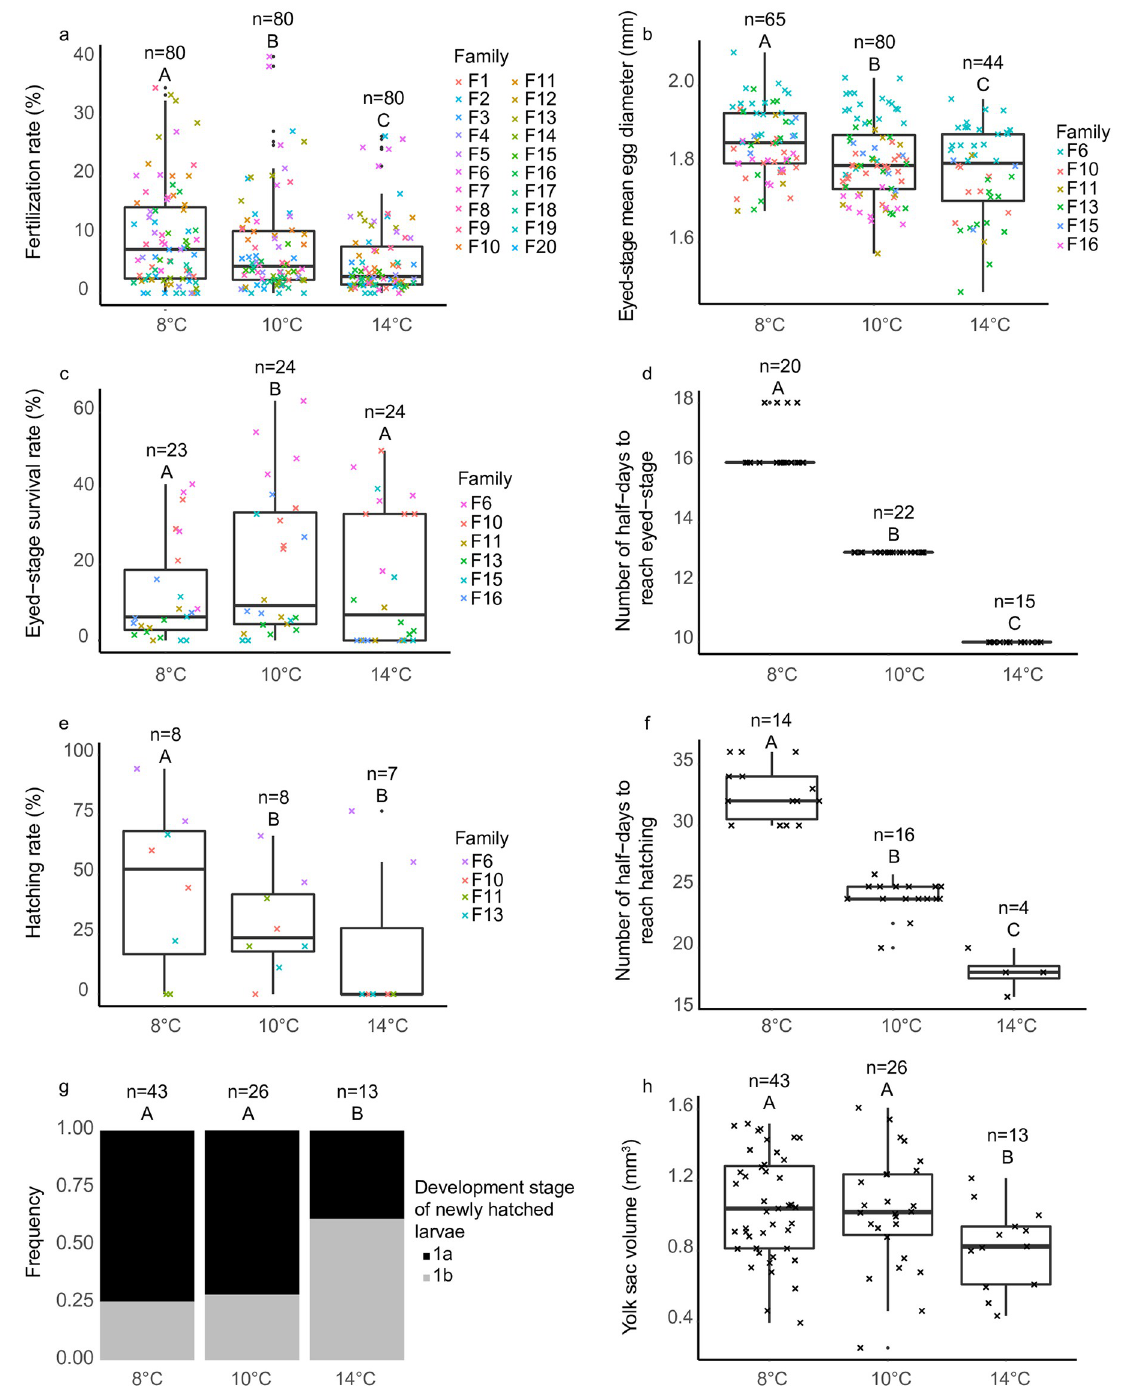
Fig 1. Impact of temperature (8˚C, 10˚C and 14˚C) on Downs herring ( Clupea harengus ) a) fertilization rate, b) eyed-stage mean egg diameter, c) eyed-stage survival rate, d) number of half-days required to reach eyed-stage, e) hatching rate, f) number of half- days required to reach hatching, g) development stage of newly hatched larvae and h) yolk sac volume. Letters in capital correspond to post-hoc results with different letters indicating statistical difference (statistical significance assigned at α = 0.05) between temperature treatments. Black cross points in graphs d, f and h correspond to sample values and black dots to boxplot outliers. When there was a significant parental effect in the model, points were colored relatively to families (graphs a, b, c and e).